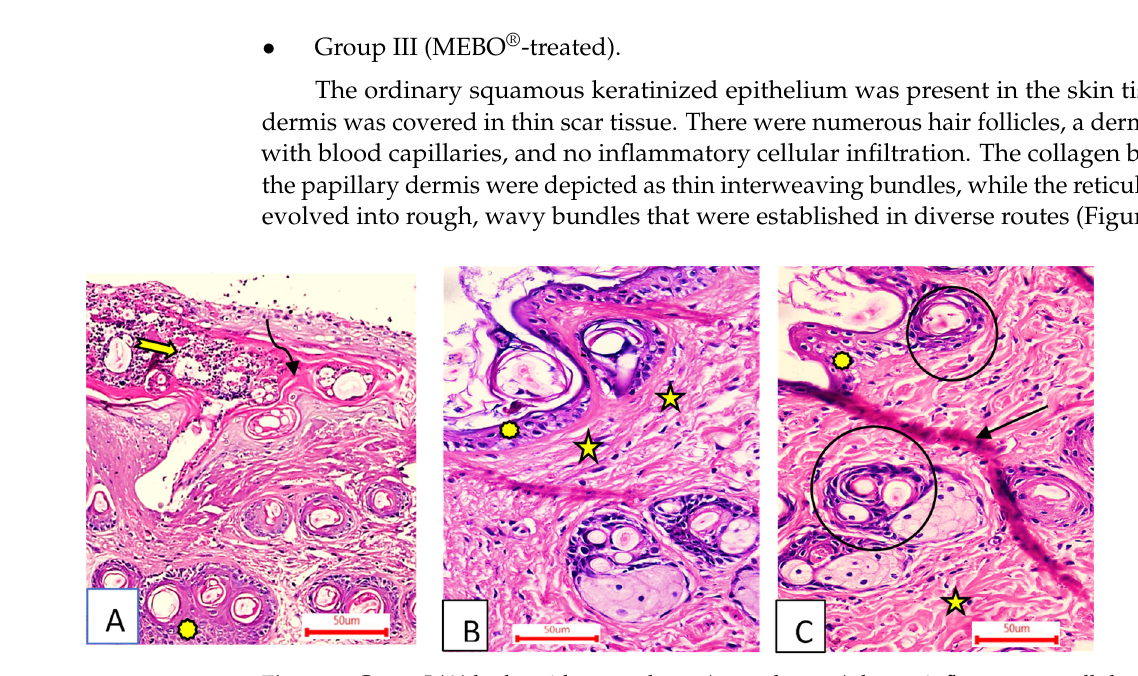
12 of 21 Figure 7. A sample of the wounded skin of individuals from each treatment group seven days after incision; Group I ( A ) showing the typical wound margin with the normal epidermis (asterisk). The wound was clogged with blood clots and granulation tissue (curved arrow). Group II ( B ) blood clot seen above the incision visible (curved arrow). Compactly arranged dermal collagen fibers are seen (aster). Group III ( C ) scar tissue (curved arrow) blocked the incision, and collagen fibers (stars) re- sembled the neighboring normal dermis with inflammatory cellular activity, particularly macro- phages (black arrows). (H & E stain ×200). Fourteen Days after Treatment • Group I (control group). The wound area was larger and heavily covered in granulation tissue, which was made up of several connective tissue layers in an acidophilic matrix and covered a signif- icant amount of inflammatory cellular infiltration. The dermis has substantial neovascu- larization and was made of thin, disordered collagen (Figure 8A).